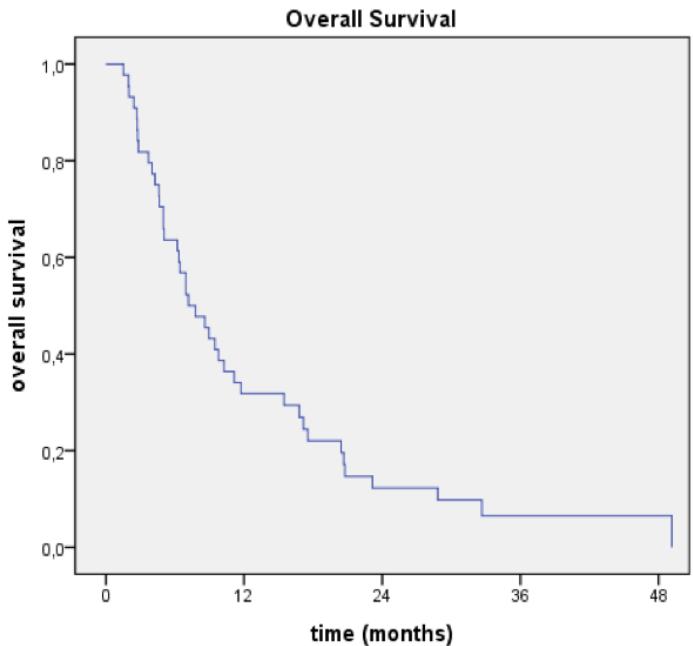
Figure 1. Overall survival for all patients.